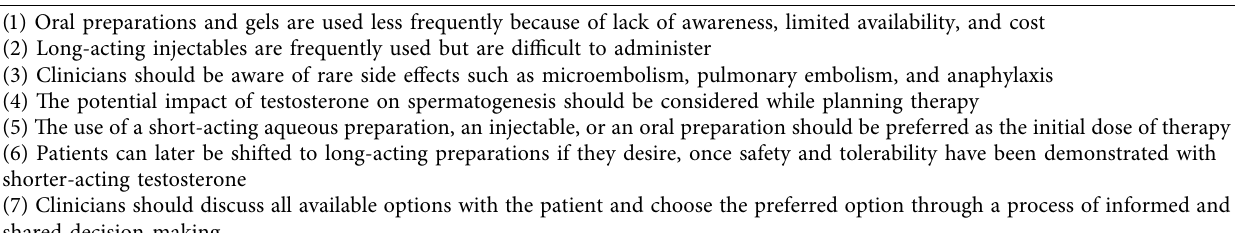
Table 5: Expert opinion on testosterone replacement